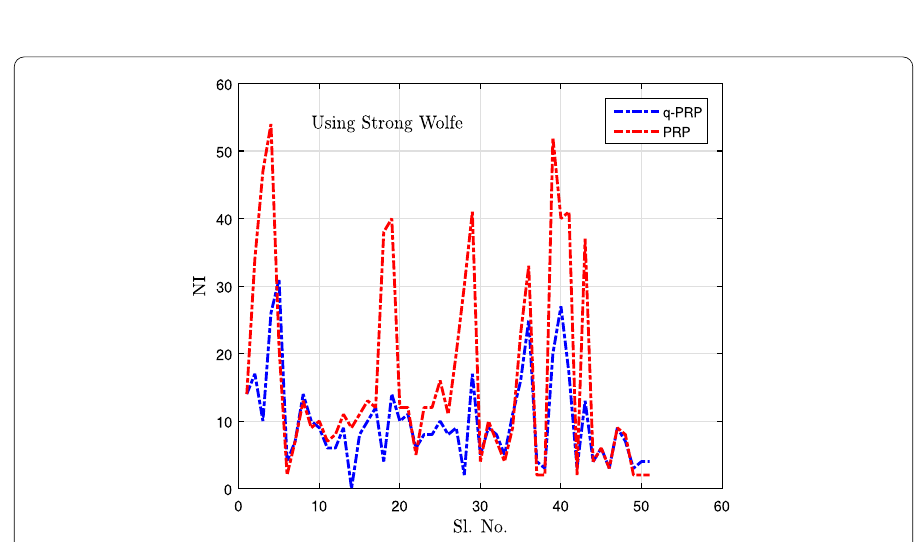
Figure 5 Graphical representation of q -PRP and PRP algorithms under strong Wolfe conditions based on Tables 4 and